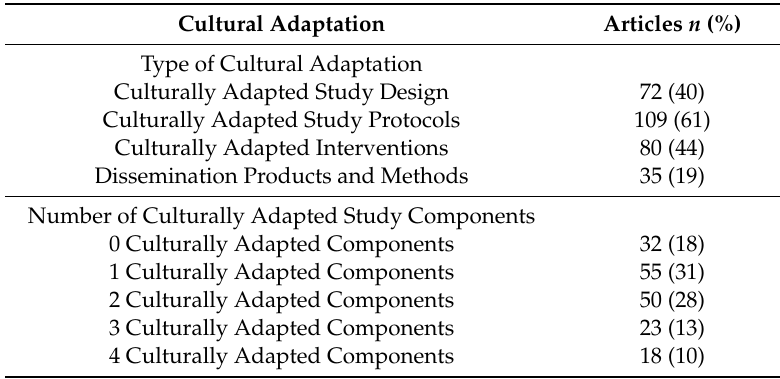
Table 4. Type and Number of Culturally Adapted Study